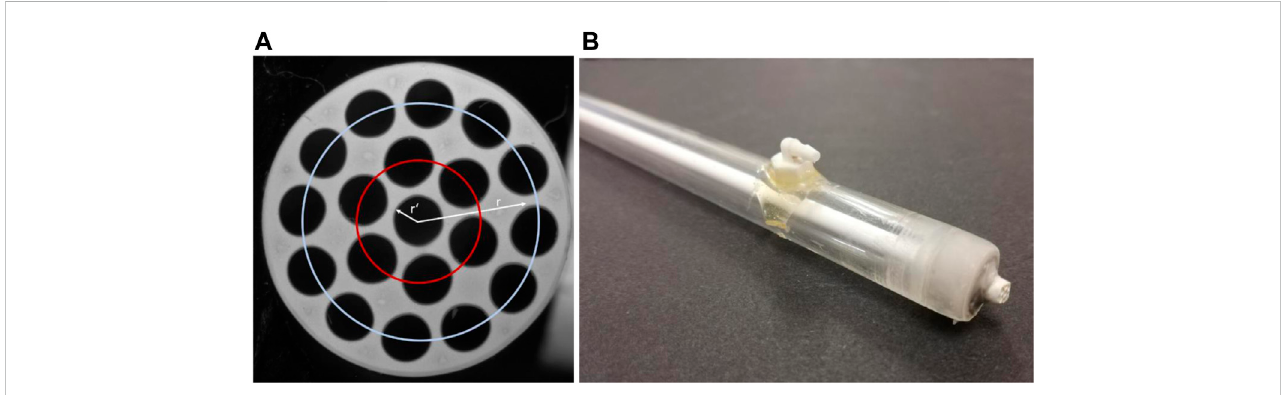
FIGURE 1 (A) Photograph of the polymeric 19-channel membrane in an axial slice. The channels are located around the central channel with inner diameters of roughly 0.7 mm. The radii are around 1 mm and 2.2 mm, respectively, for the 6-membered (red) and the 12-membered (light blue) ring of channels. Additionally, the radial coordinate r is indicated, which is the radial distance from the center. (B) Photograph of the MRI compatible fi ltration module with permeate outlet and the glued